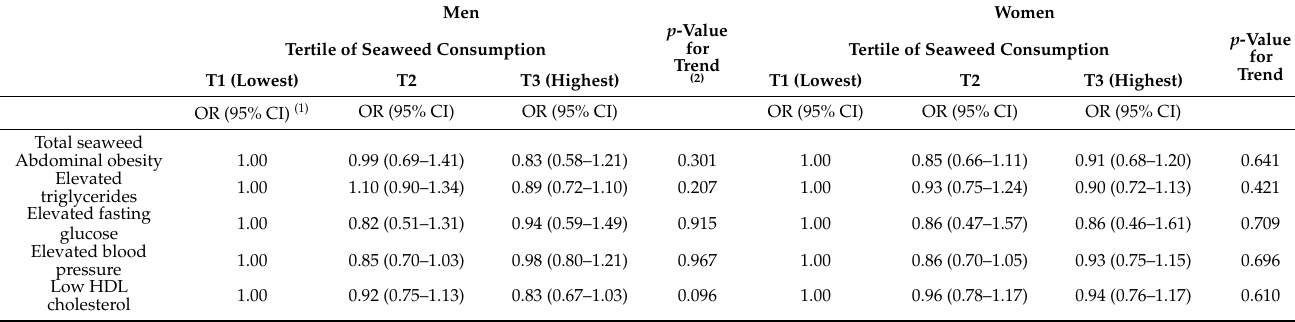
Table 4. Odds ratios (ORs) and 95% confidence intervals (CIs) of individual metabolic syndrome components according to tertiles of total seaweed, laver, and kelp/sea mustard consumption in the Korean Genome and Epidemiology Study (Ansan and